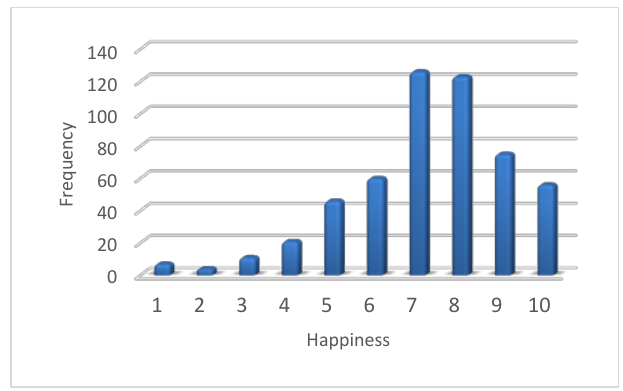
FIGURE 1: Distribution of life-satisfaction among first-year economic students at a comprehensive institution, 2013 Source: Survey data